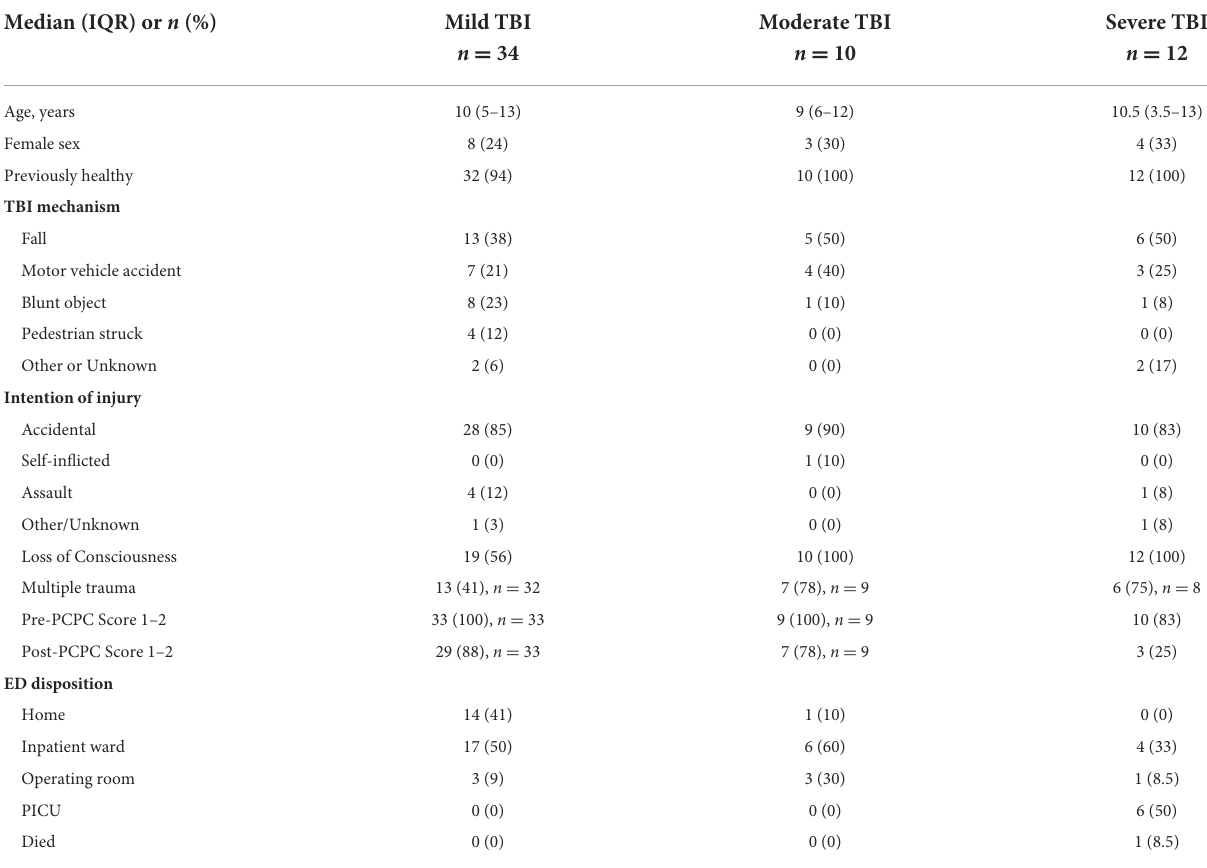
TABLE 1 Patient demographics and injury details by TBI severity.